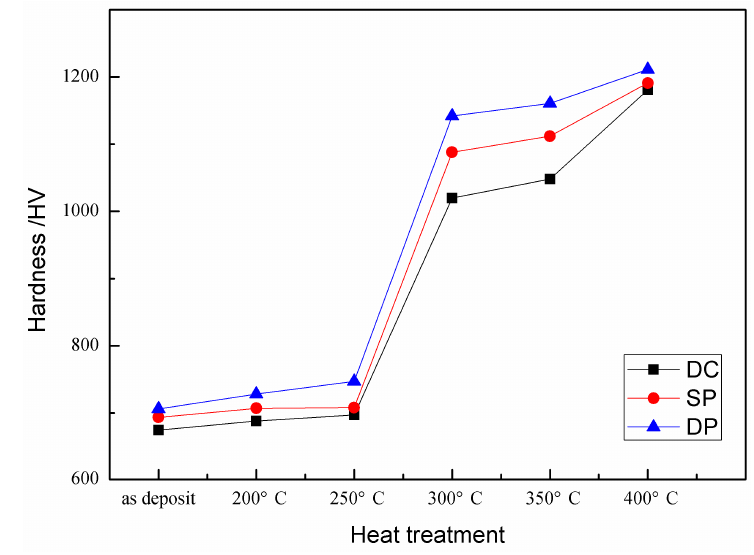
Figure 5. Microhardness of coatings after different heat treatments deposited under different current conditions.